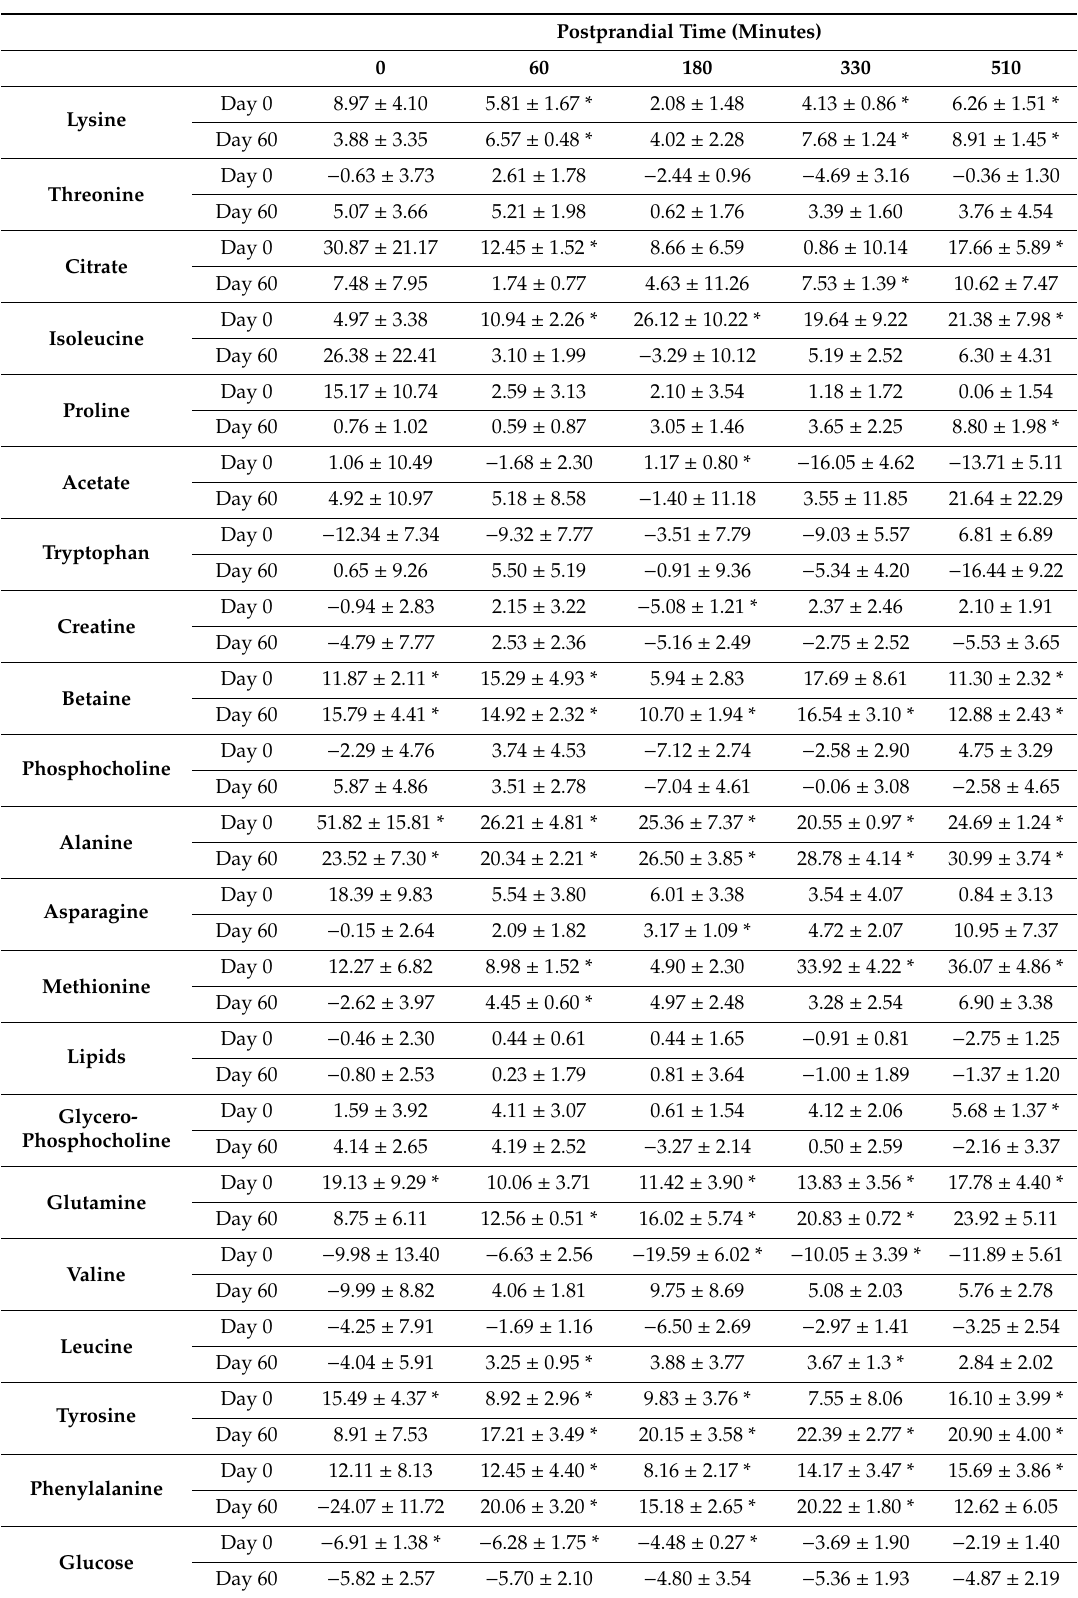
Table 1. Percentage of induction of metabolites across the